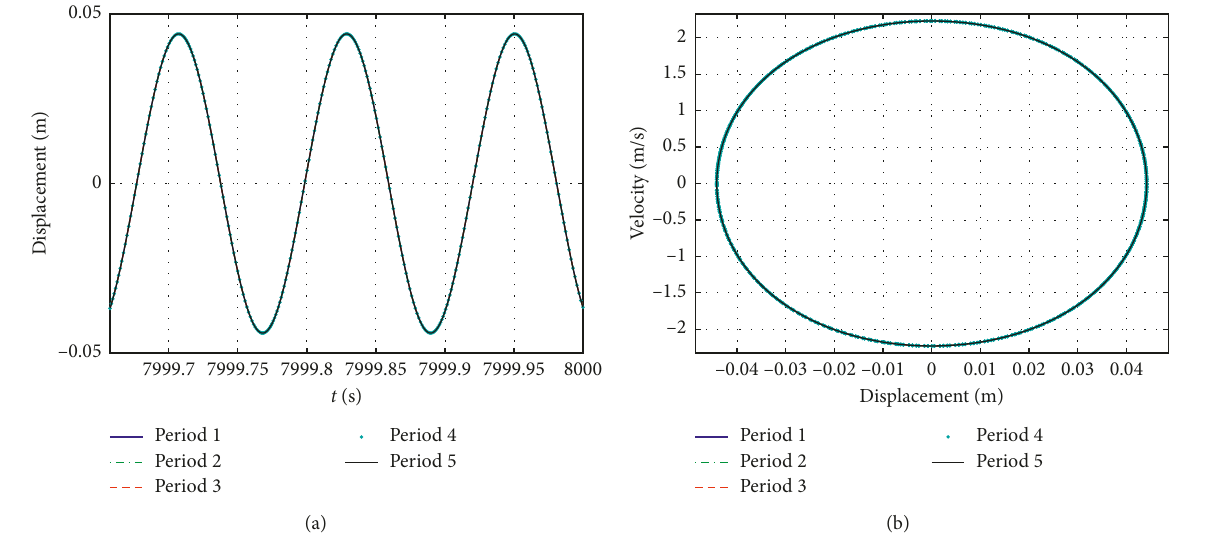
Figure 14: Five periodic shells’ (a) displacement time history curves and (b) phase diagrams.